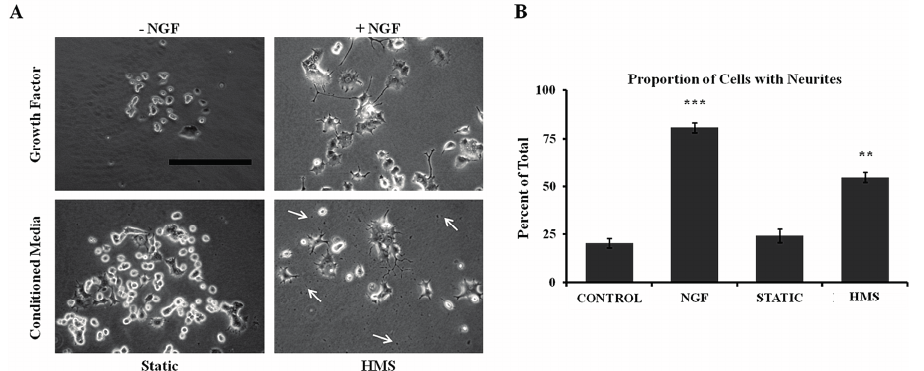
Figure 4. Conditioned media from HMS-cultured chondrocytes promotes neurite outgrowth in PC12 cells. ( A ) Representative phase images showing conditioned media from static and HMS cultured chondrocytes applied to PC12 cells and neurite outgrowth was observed and compared to vehicle ( − NGF) and NGF treated controls. White arrows in phase images indicate noticeable cell debris on dish bottoms. Scale bar: 200 μ m; ( B ) Quantification of neurite outgrowth. Error bars: ±SEM, n = 6, Student’s t -test. ** indicates p < 0.01; *** indicates p < 0.001. All samples were compared to − NGF